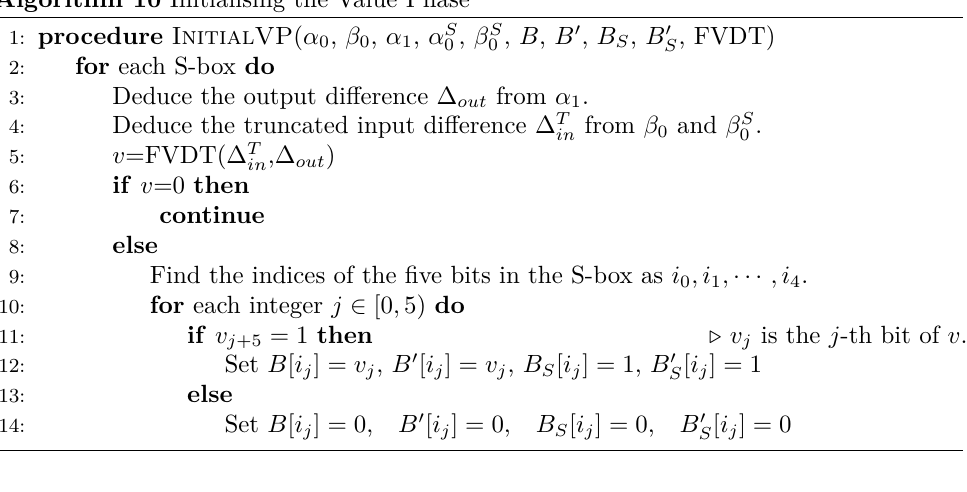
Algorithm 10 Initialising the Value Phase